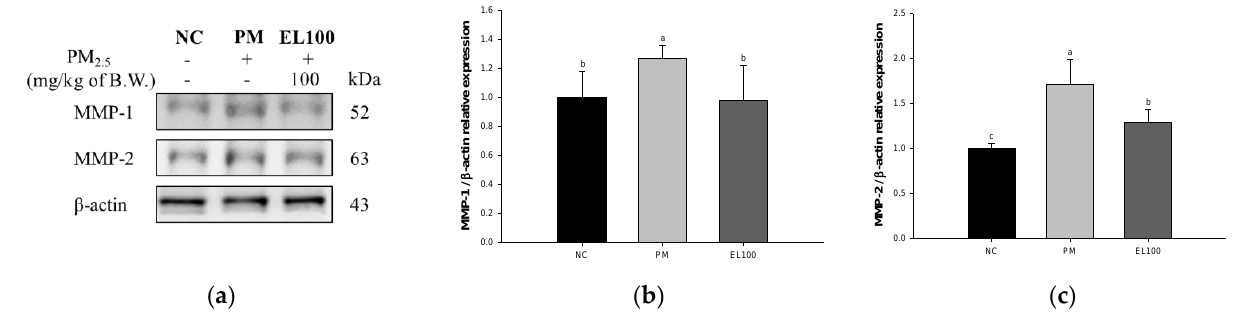
Figure 9. Protective effect of extract of Lonicera japonica on PM 2.5 -induced protein expression of Western blot images ( a ). Protein expression levels of MMP-1 ( b ) and MMP-2 ( c ). Results shown are mean ± SD ( n = 3). Data were statistically represented at p < 0.05, and different lowercase letters indicate statistical significance.